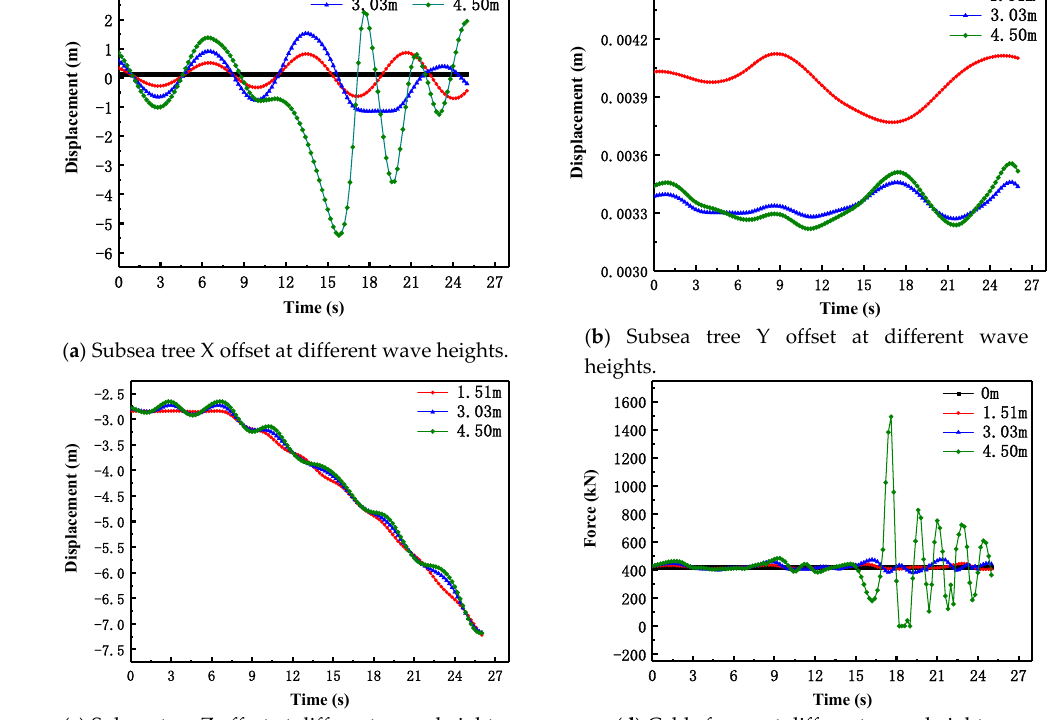
Figure 8. Subsea tree offset and cable forces at different wave heights.